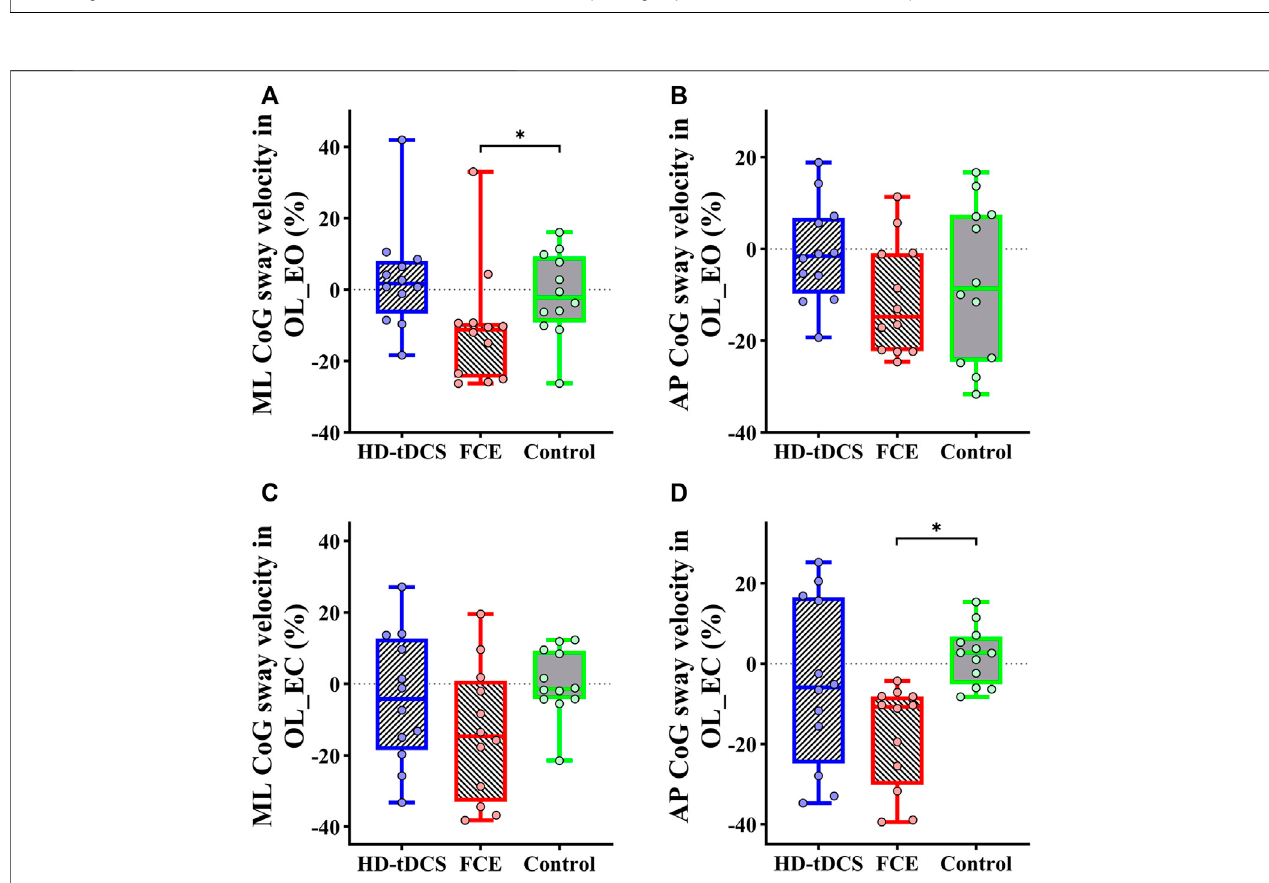
Figure 3C ) than the control group. Moreover, the